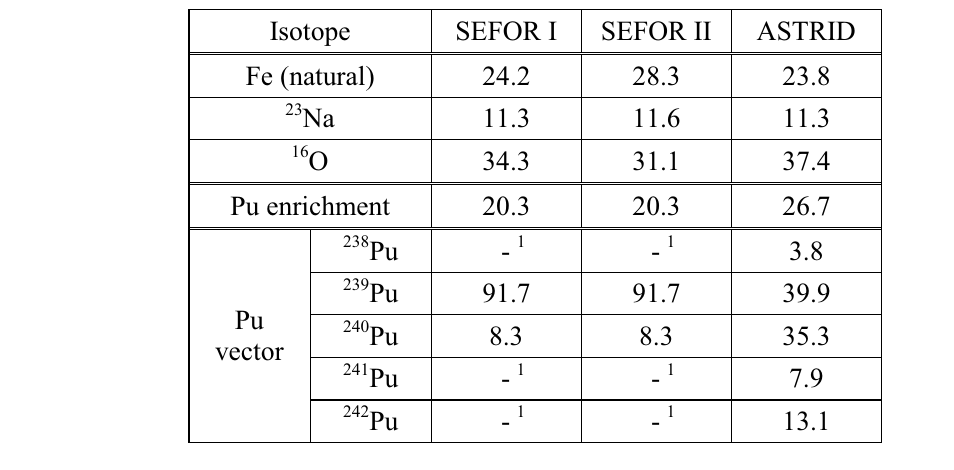
Figure 2. Direct and Adjoint flux comparison between SEFORs’ and ASTRID’s core Adjoint fluxes (light colored curves) convey the importance of a neutron of energy E It can be seen that in both SEFOR configurations, the slope of the adjoint flux at high energy (above 10 keV) is less pronounced than in ASTRID, due to the less degraded Pu vector as seen in Table III. The ASTRID Pu fuel contains numerous nuclides with fission thresholds. Table III. Atomic fraction of elements in the fuel (in %) for SEFOR Core I & II and ASTRID